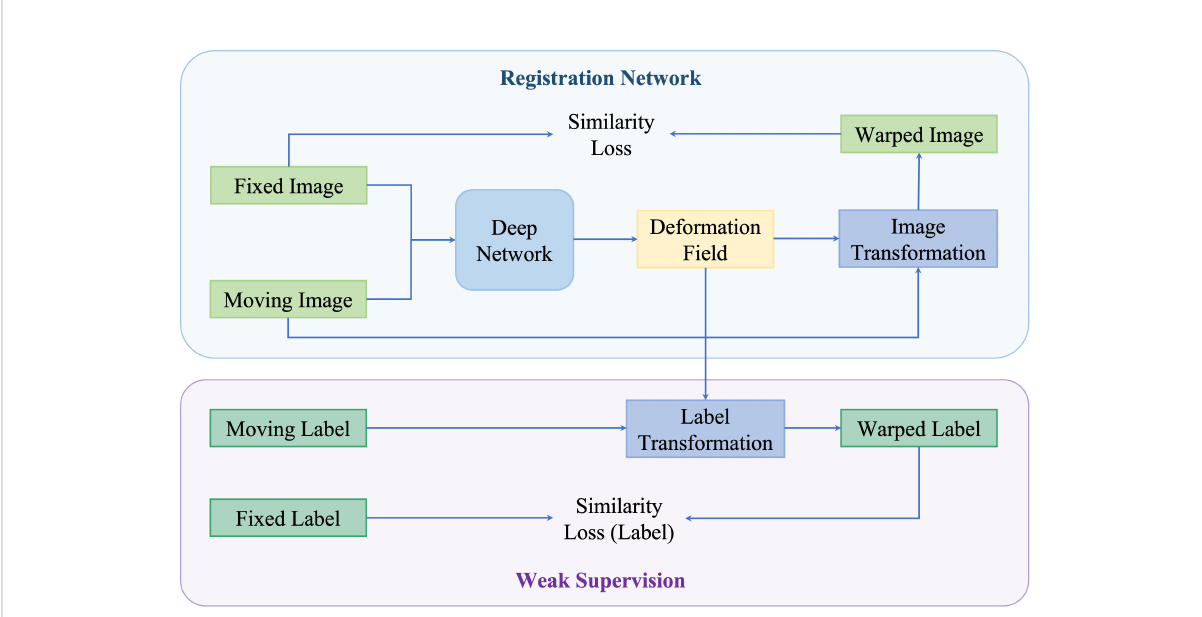
FIGURE 8 An illustration of weakly supervised deformable registration methods. The weak supervision is achieved by adding anatomical labels in the